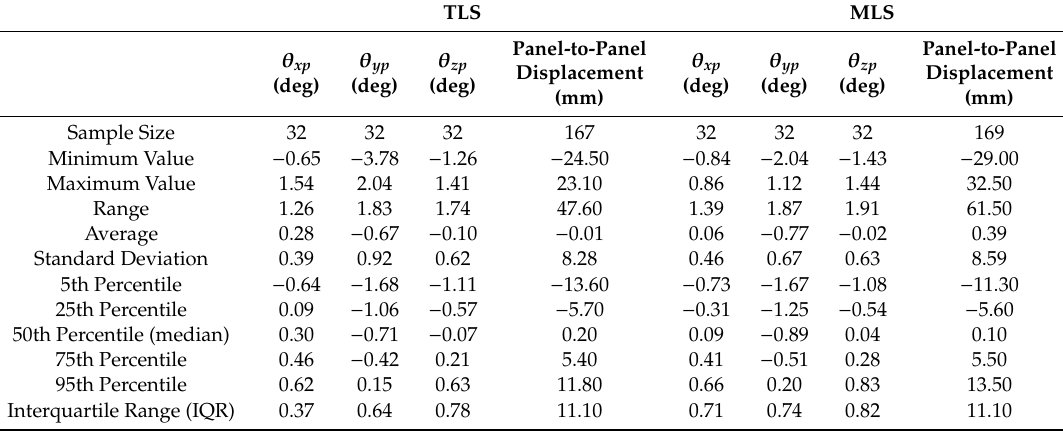
Table 7. TLS-based and MLS-based summary statistics of the derived serviceability measures for the MSE wall at